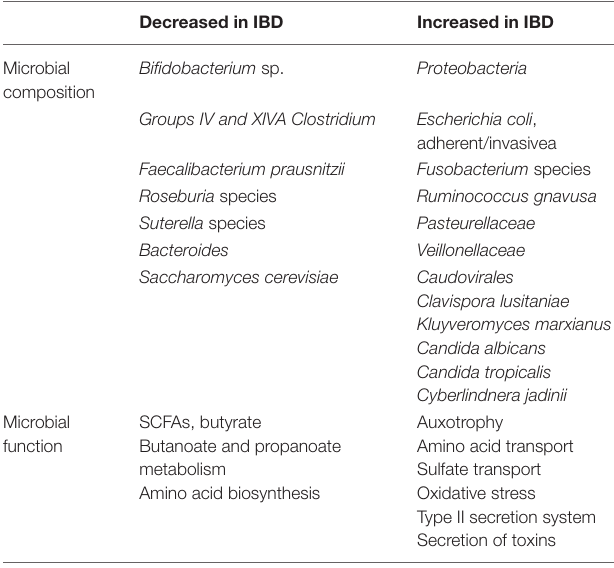
TABLE 1 | Altered gut microbiota in IBD compared to healthy individuals in humans. Decreased in